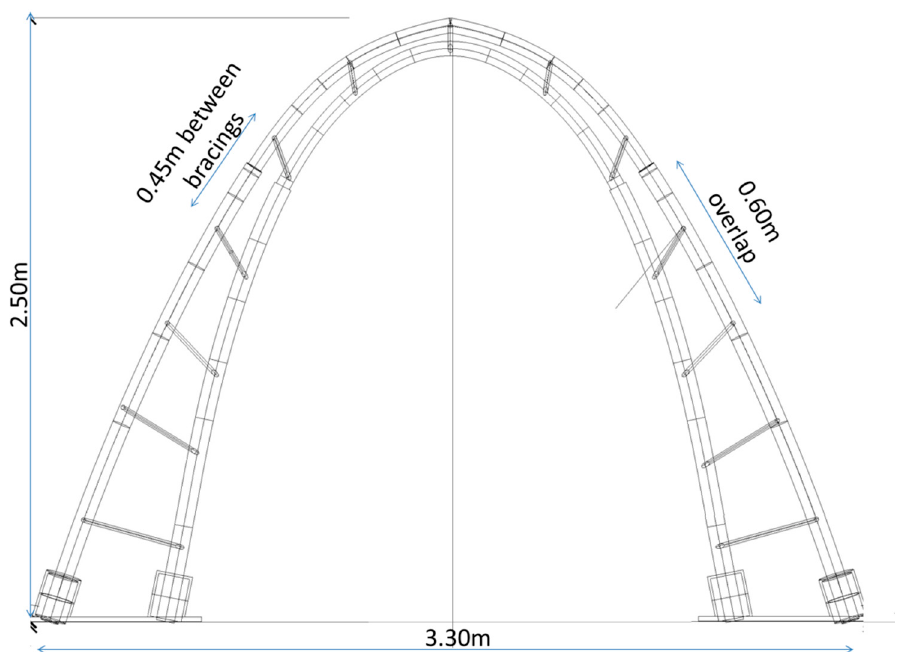
Figure 8. General dimensions of the specimen.